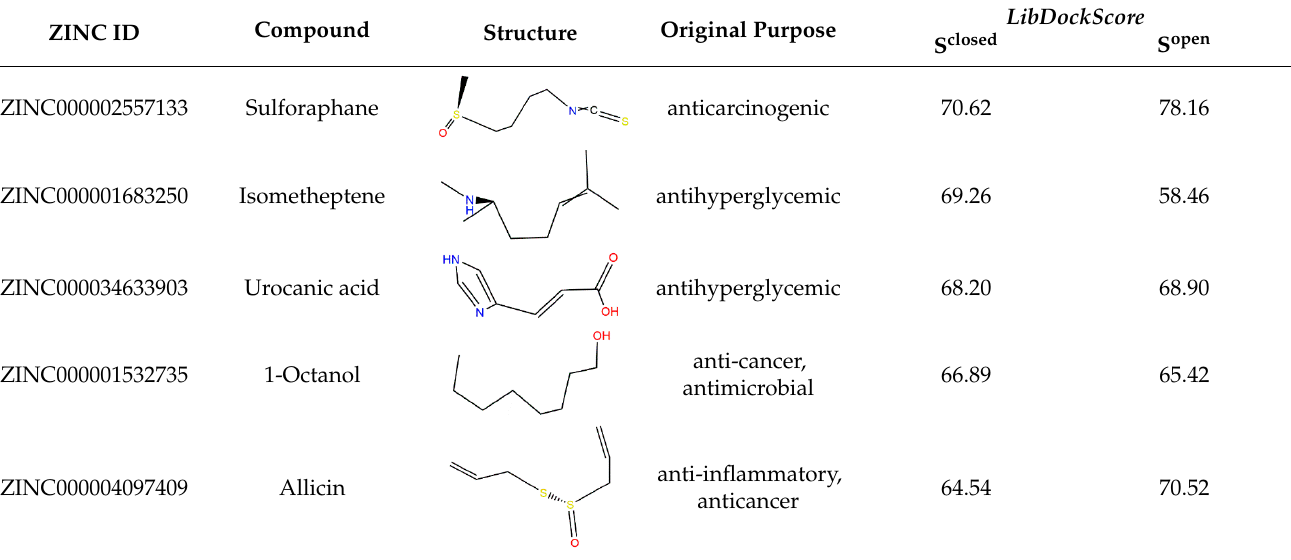
Table 1. Docking results of top-five compounds (based on LibDock Score). Table 1. Docking results of top- fi ve compounds (based on LibDock Score). Table 1. Docking results of top- fi ve compounds (based on LibDock Score). Table 1. Docking results of top- fi ve compounds (based on LibDock Score). Table 1. Docking results of top- fi ve compounds (based on LibDock Score). Table 1. Docking results of top- fi ve compounds (based on LibDock